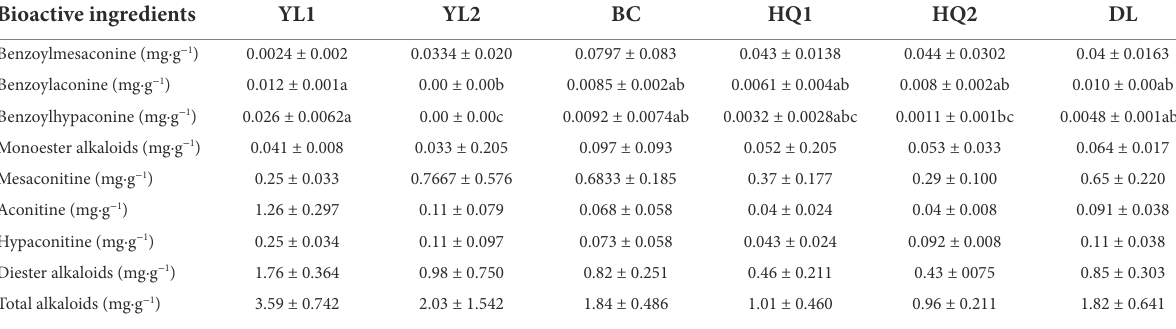
TABLE 3 Bioactive ingredients in different sample sites (means ± standard errors). Bioactive ingredients